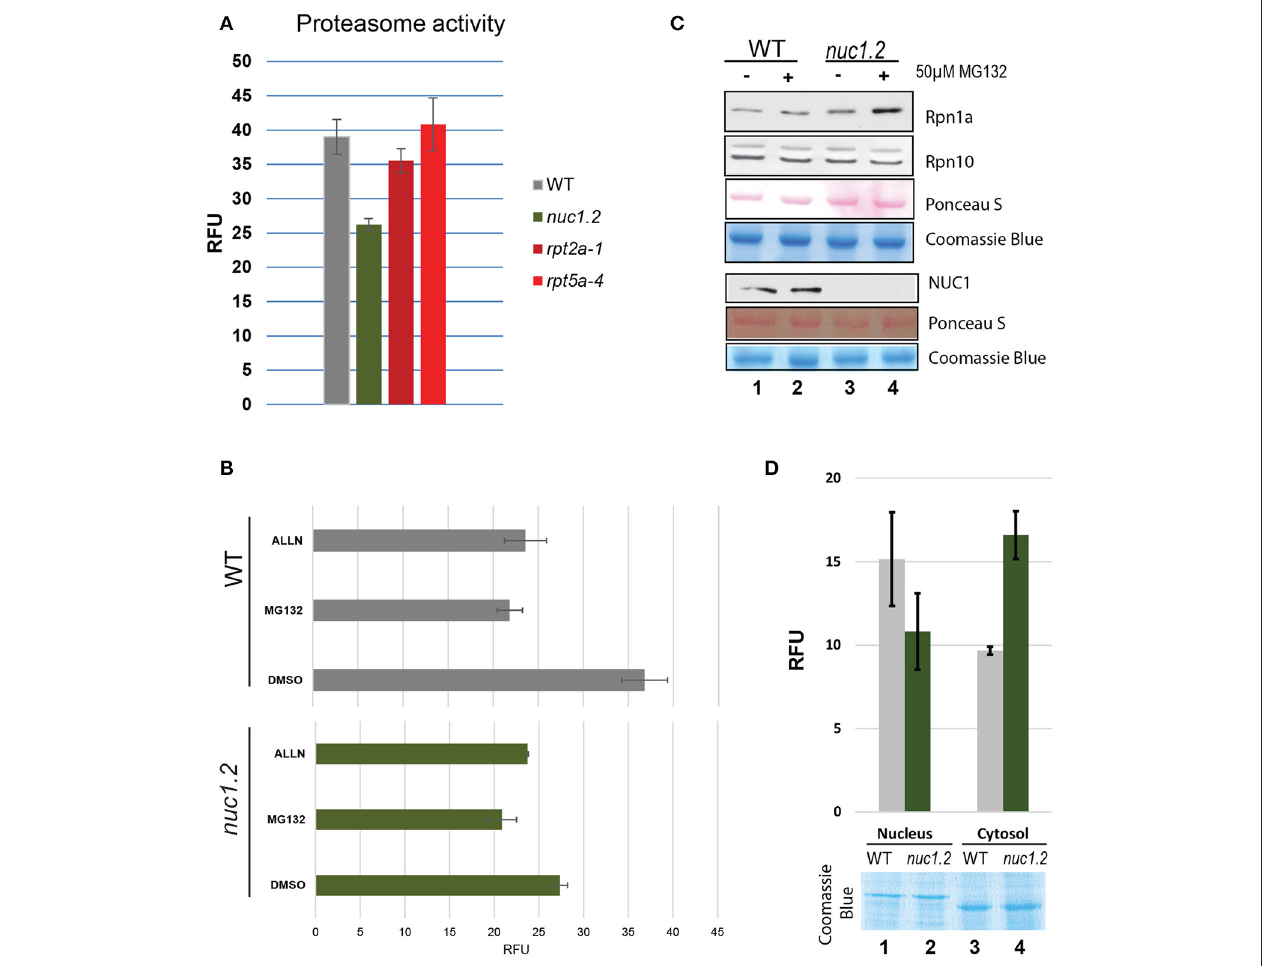
FIGURE 3 | Proteasome 26S activity in plant protein extracts. (A) The bar graph shows the proteasome activity in WT (gray), nuc1.2 (green) , rpt2-1 (dark red) and rpt5-4 (red) plant protein extracts. The 20S proteasome activity is shown in Relative Fluorescence Units (RFU). (B) Histogram of proteasome activity in WT (gray) and nuc1.2 (green) protein extracts from plants treated with proteasome inhibitors MG132 or ALLN. Reactions without proteasome inhibitors (DMSO only) were used as control. (C) Western blot analysis to determine the protein level of Rpn1a and Rpn10 proteasome subunits in WT and nuc1.2 mutant plants. Gels and membranes were stained with Coomassie blue or S- Ponceau respectively to verify similar amount of protein in each sample. (D) Histogram of proteasome activity in nuclear and cytoplasmic fractions from WT (gray) and nuc1.2 (green) protein extracts. Gel was stained with Coomassie blue to verify similar amount of protein in each sample. Standard deviation of 3 independent experiments in (A,B) and (D) is